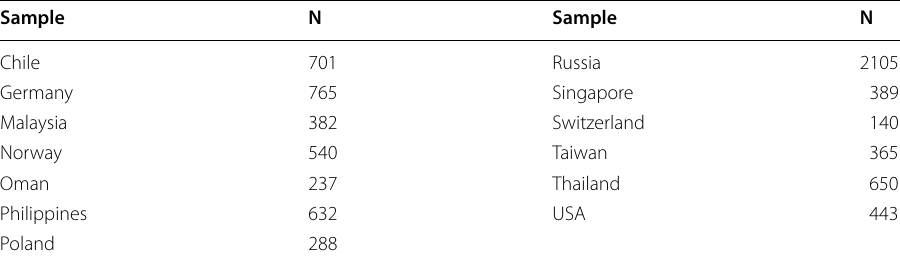
Table 1 Sample sizes (cases with missing values on all variables and teacher preparation units with less than four future teachers were excluded)